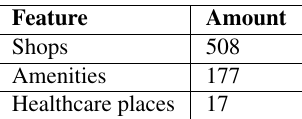
Table 4. Mapping results of the third course meeting. Source: